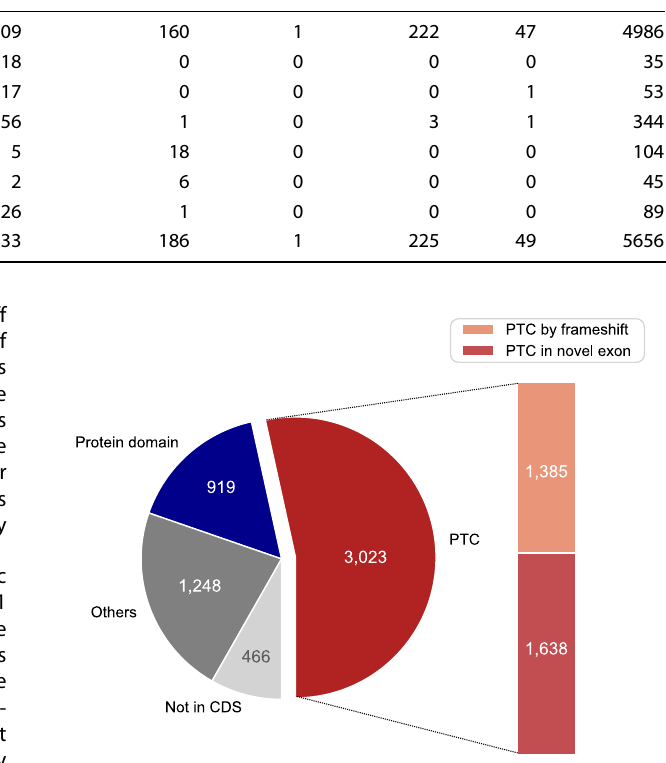
Table 1. Classi fi cation of the 5656 SCMs using ANNOVAR and ClinVar.